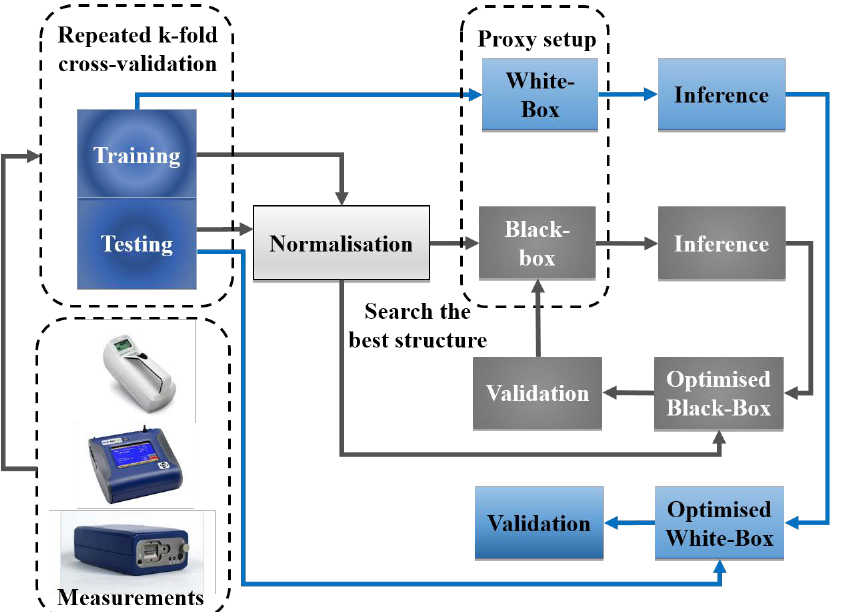
Figure 3. The procedure of the modelling processes for the white-box (WB) and black-box (BB)